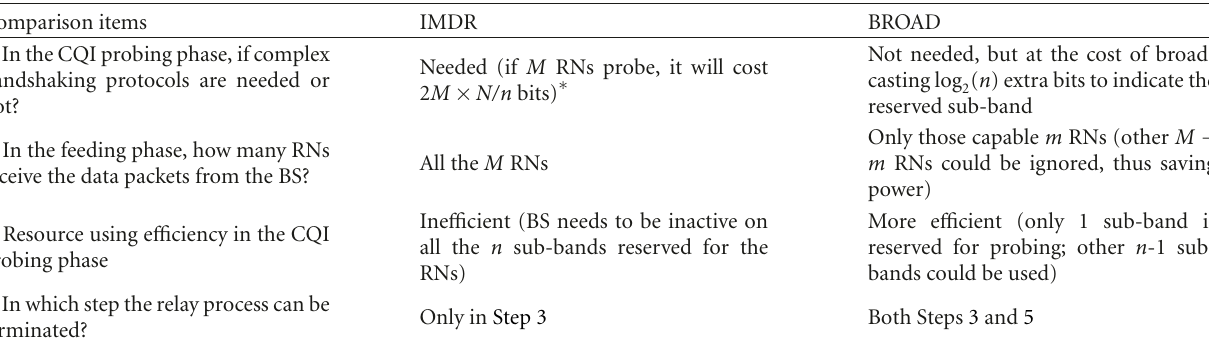
Table 4: Overhead comparisons between BROAD and IMDR.